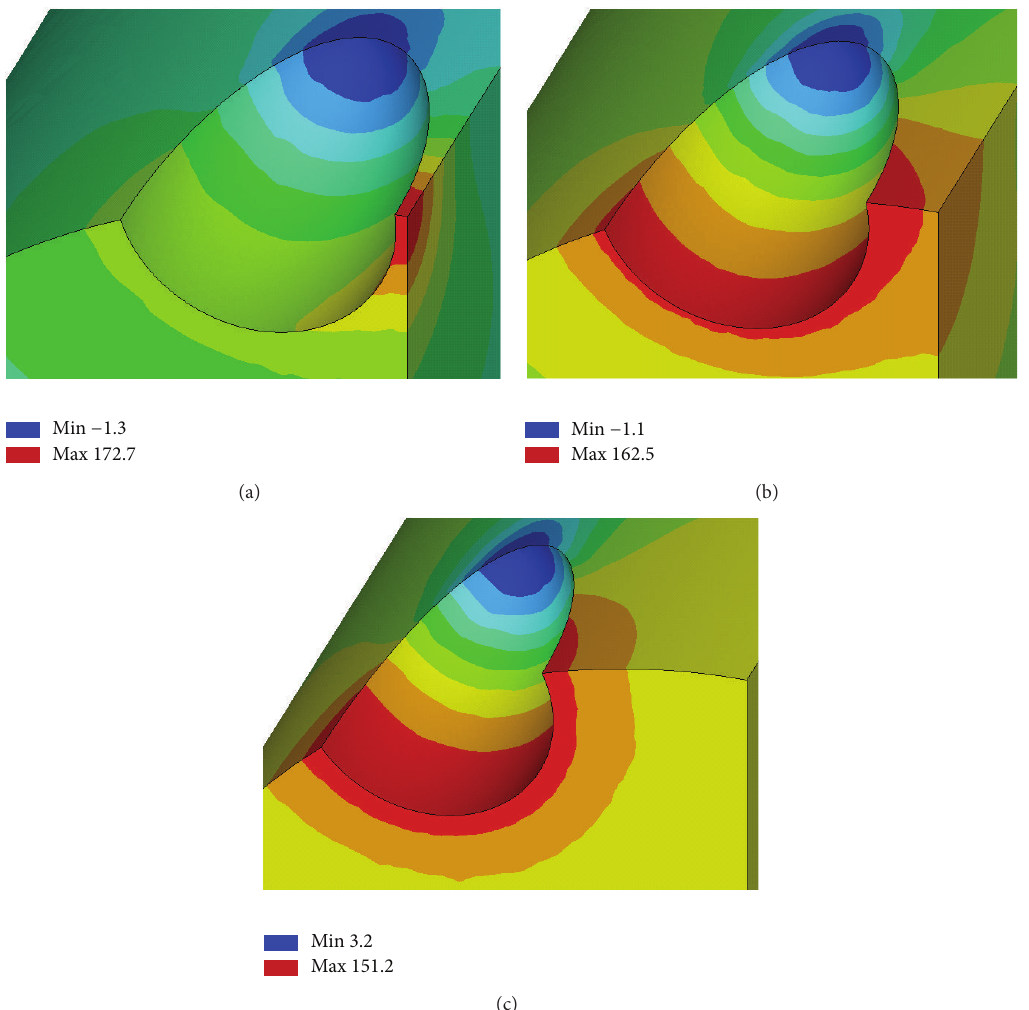
Figure 9: Stress distributions near the pit with various angles: (a) 𝜃 = 25 ∘ , (b) 𝜃 = 35 ∘ , and (c) 𝜃 = 60 ∘ .